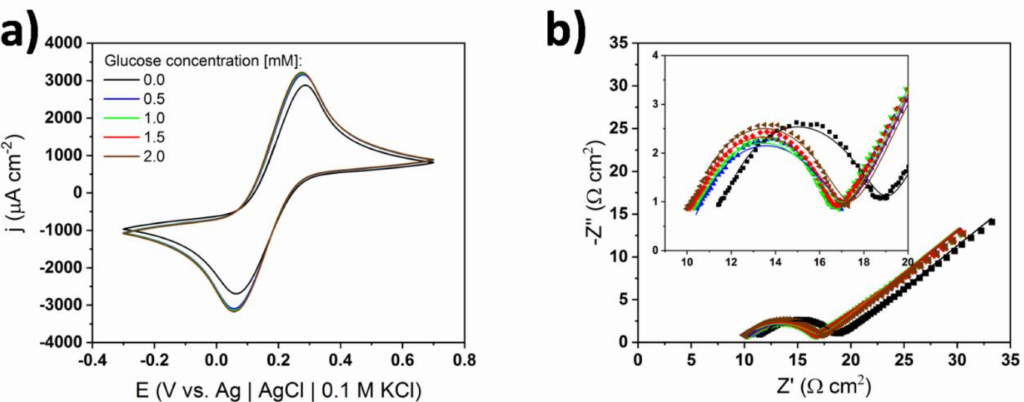
Figure 5. ( a ) Cyclic voltammograms, and ( b ) electrochemical impedance spectroscopy (EIS) spectra of bare TiND | AuNP electrode registered for di ff erent concentrations of glucose in 1 X cPBS containing 10 mM of ferrocyanide redox pair; inset—magnification in the 10–20 Ω cm 2 range. Dotted lines correspond to measured impedance data and continuous lines to fitted